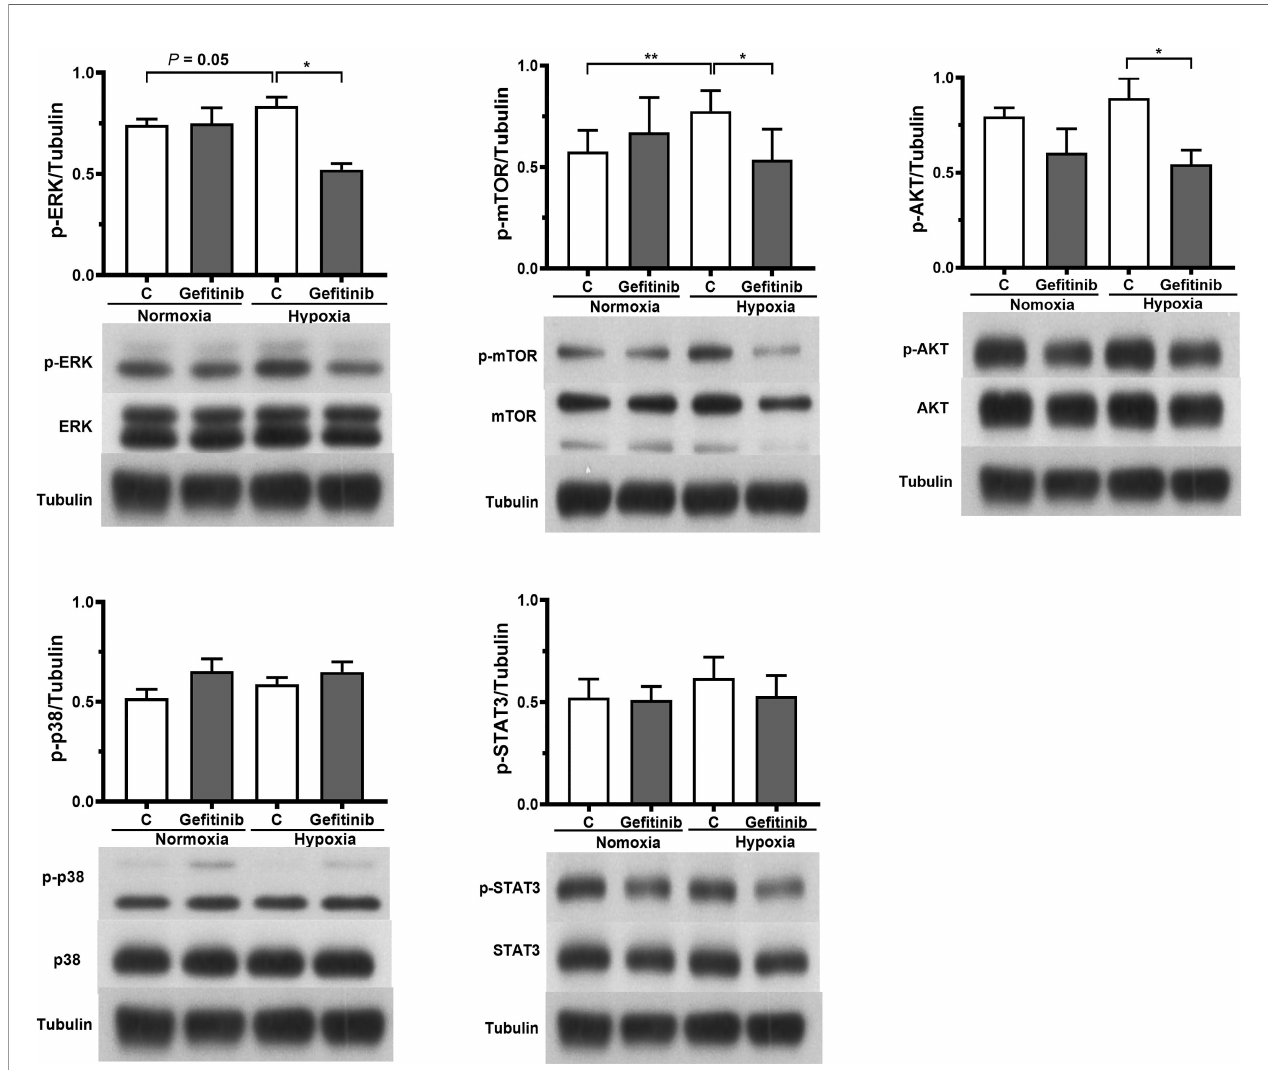
FIGURE 7 | Western blot analysis was used to quantify the expression of MAPK kinase (p-38), extracellular signal-regulated kinase (ERK), phosphatidylinositol-3- kinase/protein kinase B (PI3K/AKT), signal transducer and activator of transcription-3 (STAT-3), and mammalian target of rapamycin (mTOR) in MRC-5 human fetal lung fi broblasts (n=4), which were exposed to normoxic (O 2 20%) or hypoxic (O 2 5%) condition and in the absence or presence of ge fi tinib (1 m M) for 24 hours. * P <0.05, ** P < 0.01 compared with control. C, control; p-,